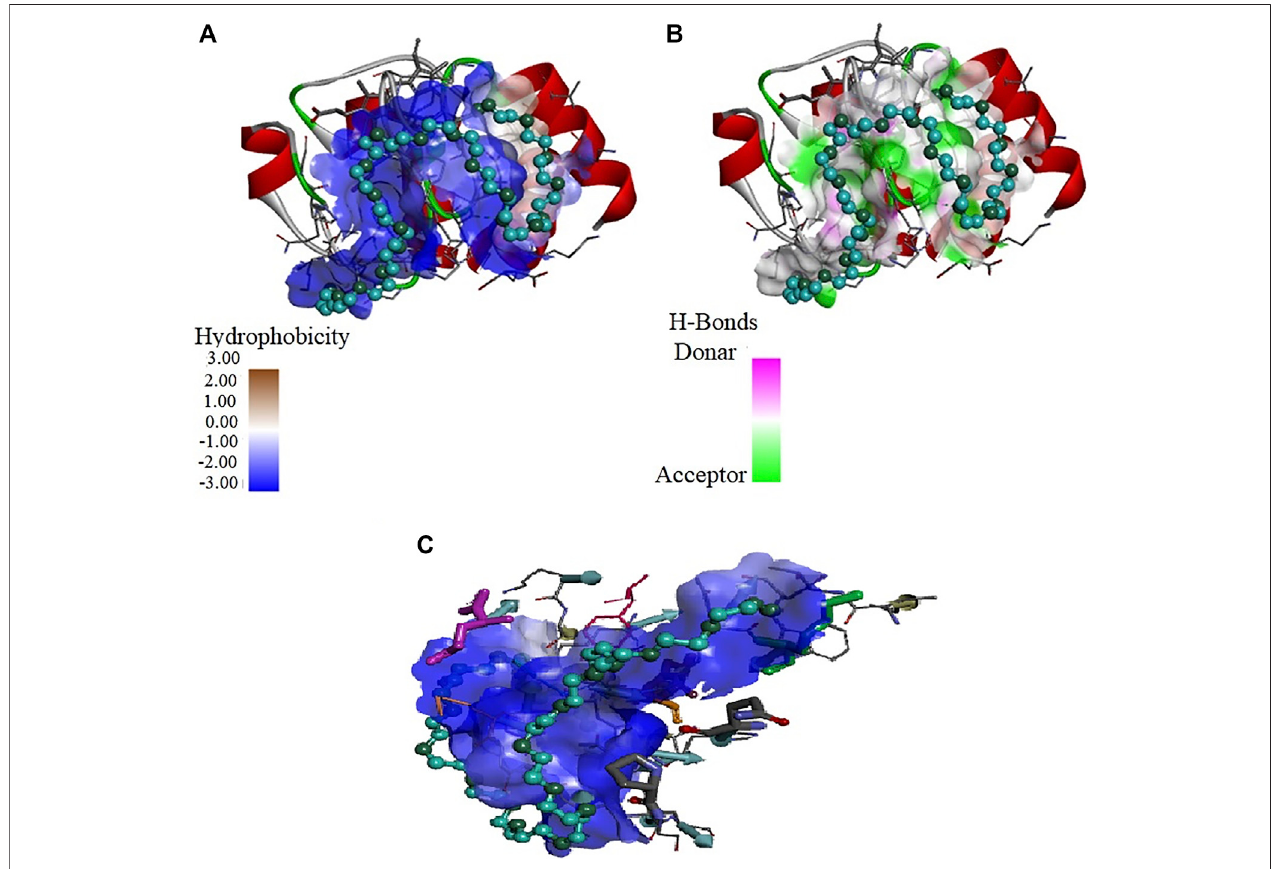
FIGURE 9 | Values of (A) hydrophobicity and (B) H-bonds (acceptor and donor) on the surface of cyt c interacting with PEG 20. (C) Porcupine plot shows hydrophobic moment outlines in the form of an arrow directing possible amphiphilic α -helical regions on the protein on interaction of PEG 20.